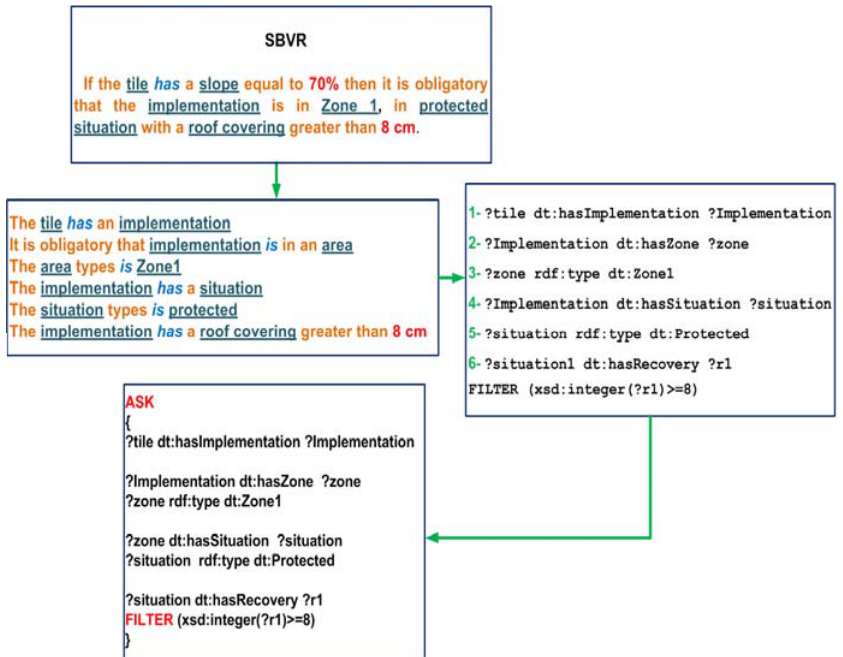
Figure 5. Transforming SBVR into SPARQL